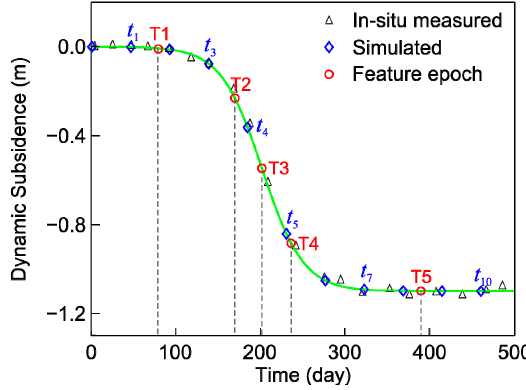
Figure 2. Simulated dynamic subsidence at a ground surface point. Table 1. Revisit cycles of the five common satellites with SAR sensors, and the number of their simulated InSAR observations.